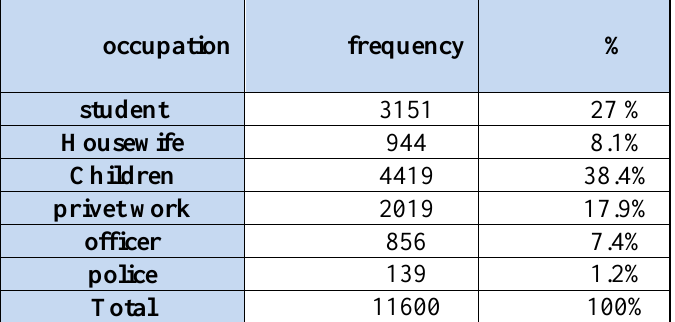
Table (4) distribution of study sample by